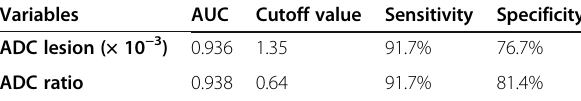
Table 3 AUC, optimal cutoff values, and corresponding performances of ADC value and ADC ratio for differentiation between clear cell RCC and non-clear cell RCC lesions Variables